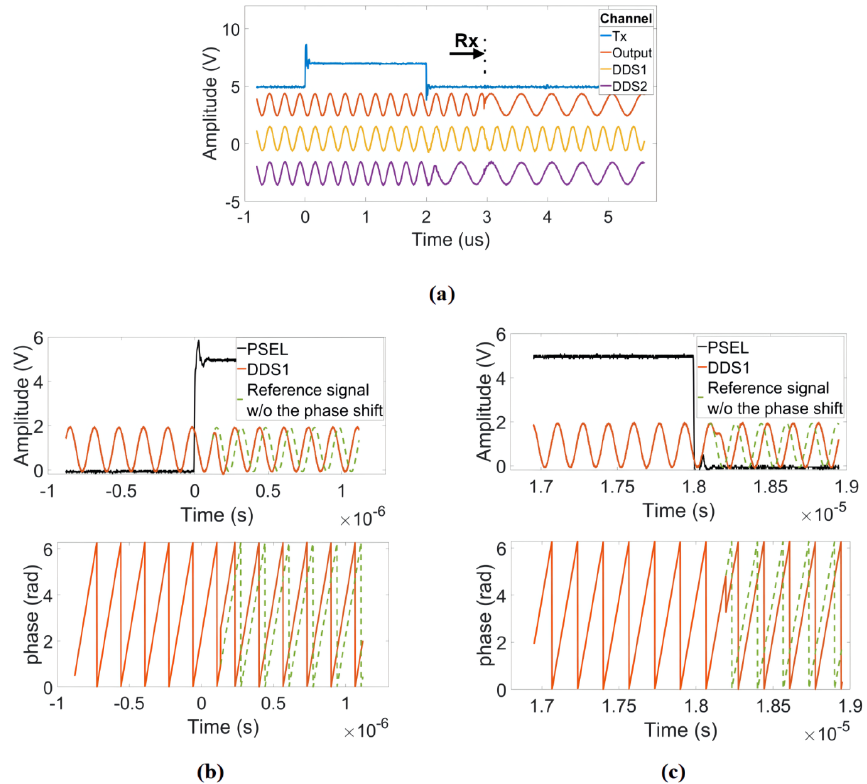
Figure 5. Illustration of the timing of the proposed DDS-based reference signal generator. (a) Frequency shift in the receiver DDS at the falling edge of the excitation pulse with a phase that is synchronous with the current transmitter phase. (b, c) Amplitude and phase response to ± 90 ◦ phase shifts at the rising edge and falling edge of the PSEL digital